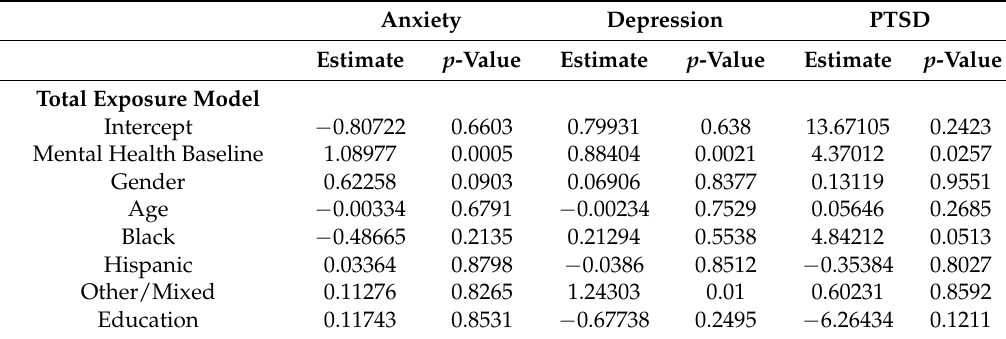
Figure 1. Association between hurricane exposure (personal, property, personal + property) and mental health at follow-up (anxiety, depression, PTSD symptoms). Models were adjusted for age, gender, race, education, medical insurance, existing mental health conditions, elapsed time between Hurricane Sandy and baseline, and mental health condition at baseline. Table 3. Association between exposure and mental health symptoms.